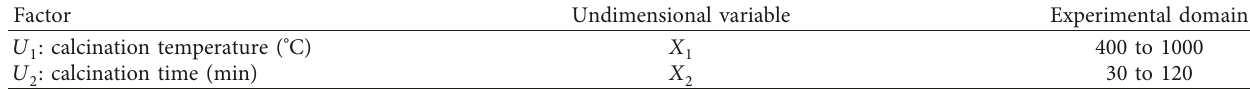
Table 1: Experimental domain for the Doehlert experimental design.